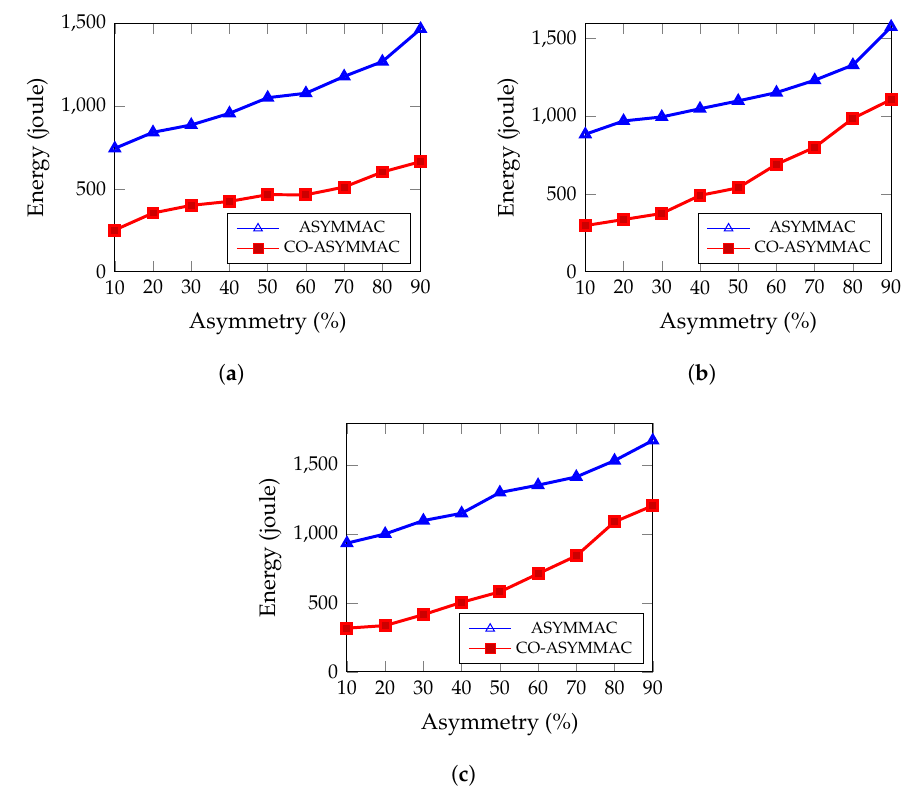
Figure 9. Average energy consumption: ( a ) for 27 nodes; ( b ) for 54 nodes; and ( c ) for 90